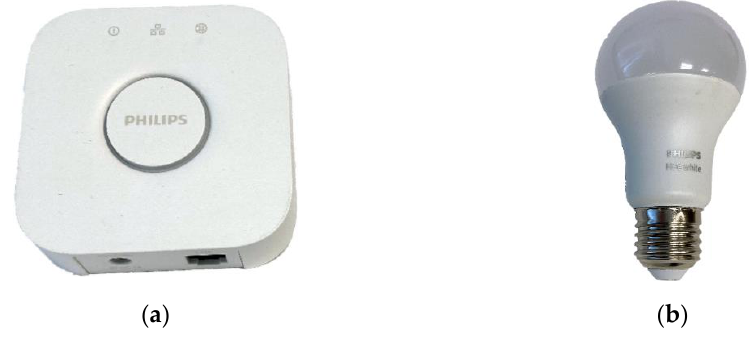
Figure 7. Philips Hue lighting system: ( a ) Philips Hue Bridge 2.0; ( b ) Smart LED bulbs Philips Hue White 9W E27 model LWB010.